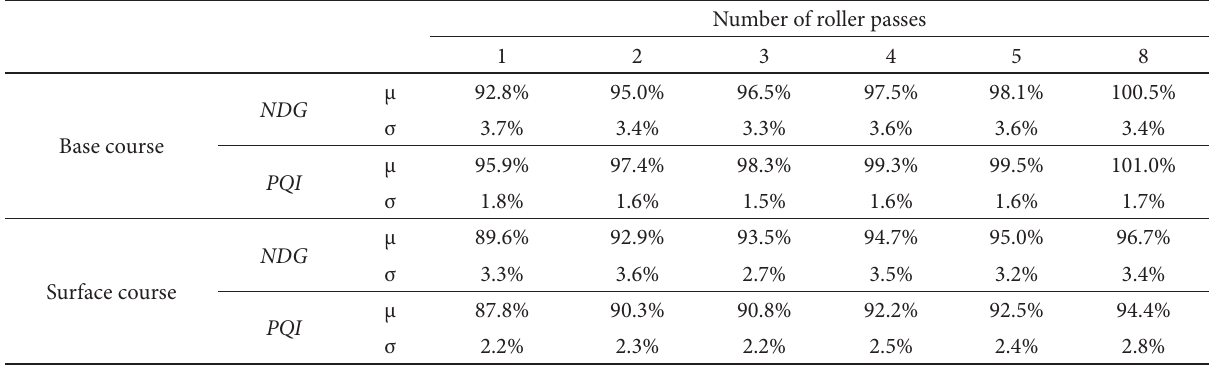
table 4. Mean (μ) and standard deviation (σ) of CD after N roller passes, per layer type and measurement equipment